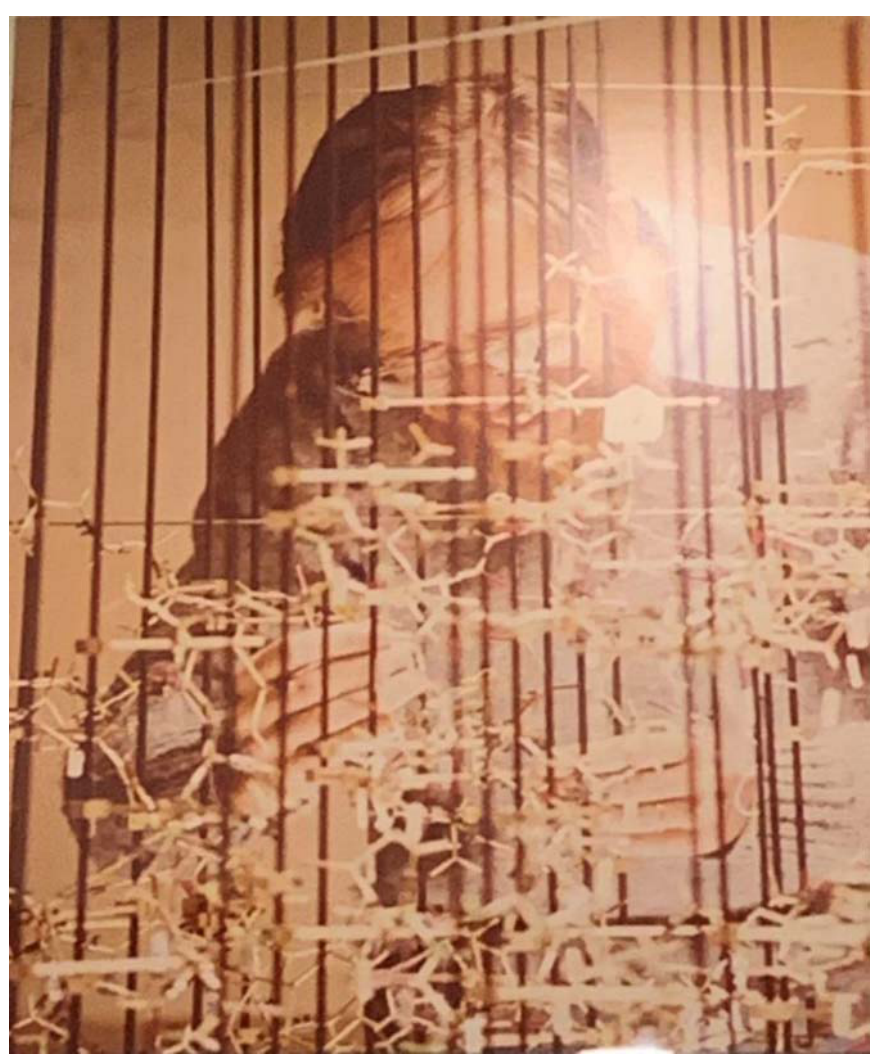
Figure 3. Michael’s smile when looking at structures.